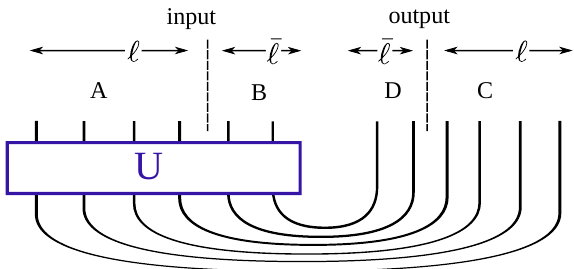
Figure 2 . Pictorial representation of the state U de(cid:12)ned in eq. (2.8). The operator U is depicted j ii as a box, while its legs correspond to the local Hilbert spaces h j . The output legs are bent to create 0 a state in a doubled Hilbert space . Each space is partitioned into two regions: A and B N H N (cid:10) H 0 for the input space , and C and D for the output space N H N H